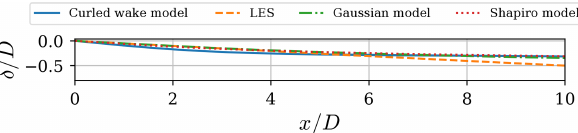
Figure 9. Wake displacement δ nondimensionalized by rotor diam- eter, D , along the spanwise coordinate as a function of nondimen- sional downstream location, x/D